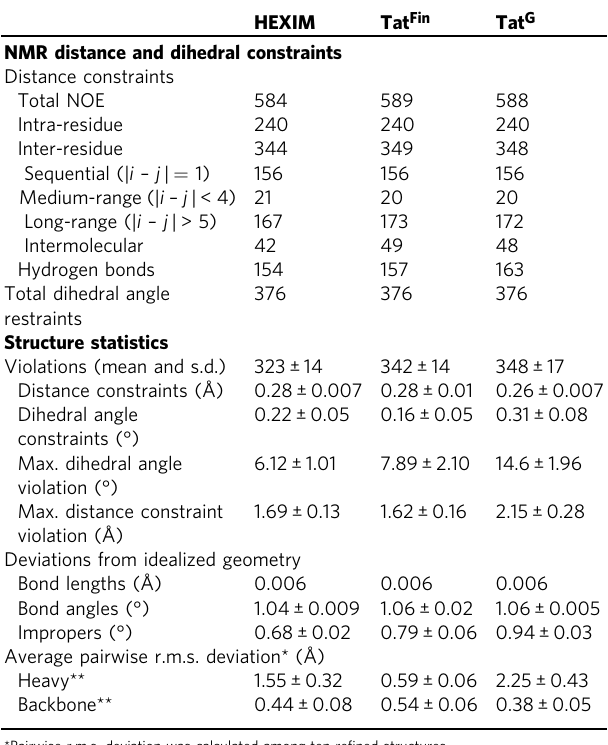
Table 1 NMR and re fi nement statistics for HEXIM, Tat Fin , and Tat G ARMs in complex with 7SK-SL1 apical-AGU